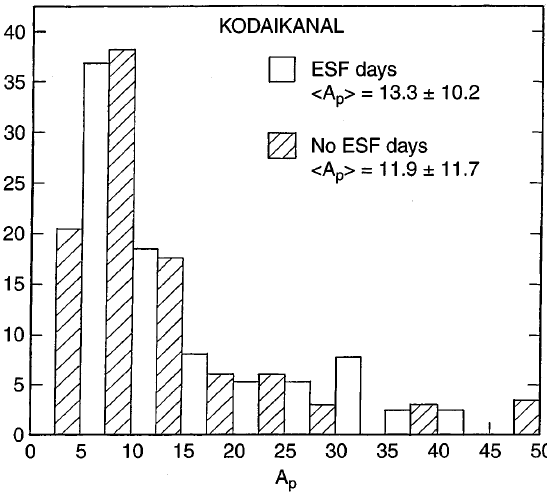
Fig. 3. Distribution of the daily values of geomagnetic A p index for nights with and without post-midnight onset of spread-F at Kodaikanal. Mean levels of the index are also given for the two sets of